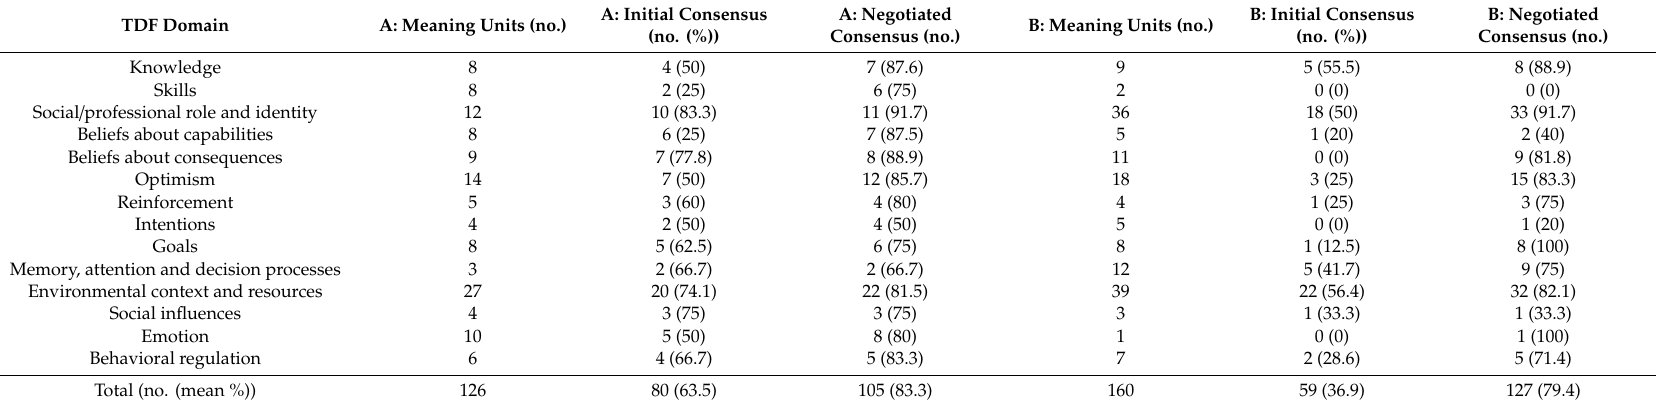
Table 1. Intercoder agreement on meaning